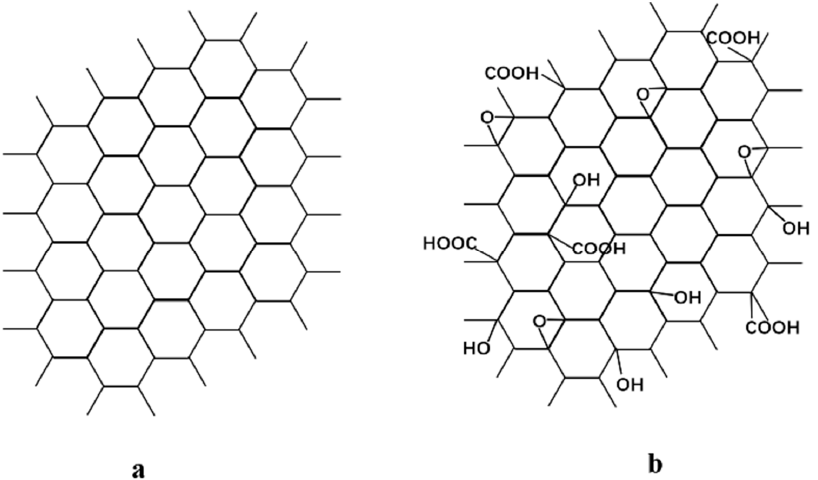
Figure 1. Chemical structure of ( a ) graphene and ( b ) graphene oxide.